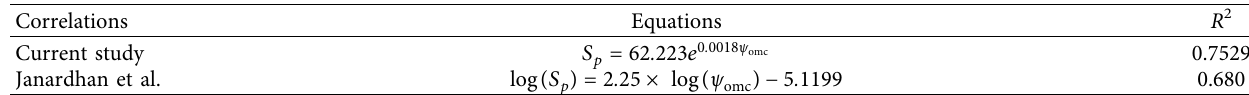
Table 6: Selected regression equations considered for validation purpose.